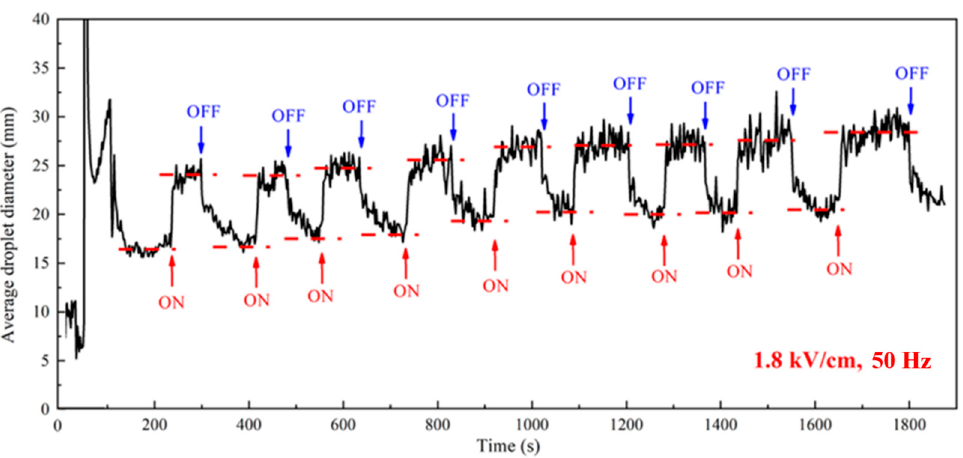
Figure 6. Average water droplet diameters.